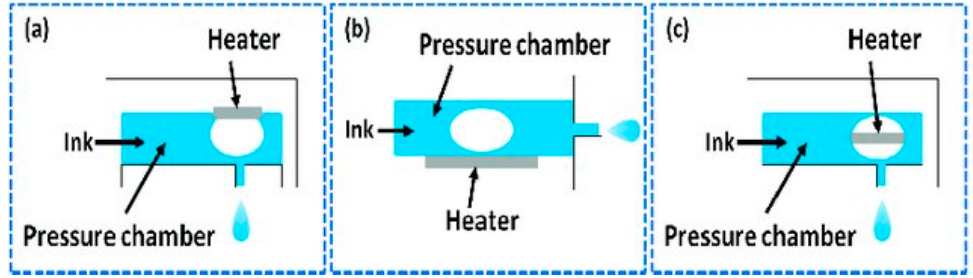
Figure 7. ( a ) Roof shooter, ( b ) side shooter, and ( c ) back shooter system